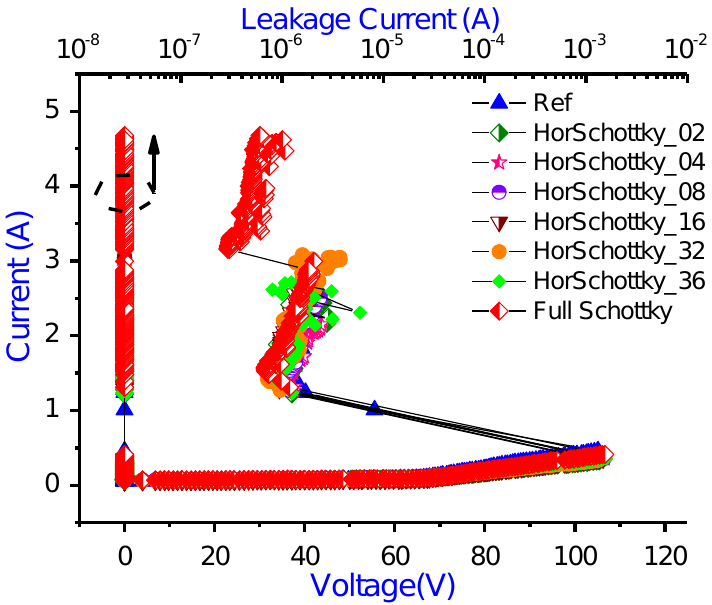
Figure 5. Snapback I-V curves and leakage currents of HV nLDMOSs with the drain electrode-embedded horizontal Schottky rows modulation.